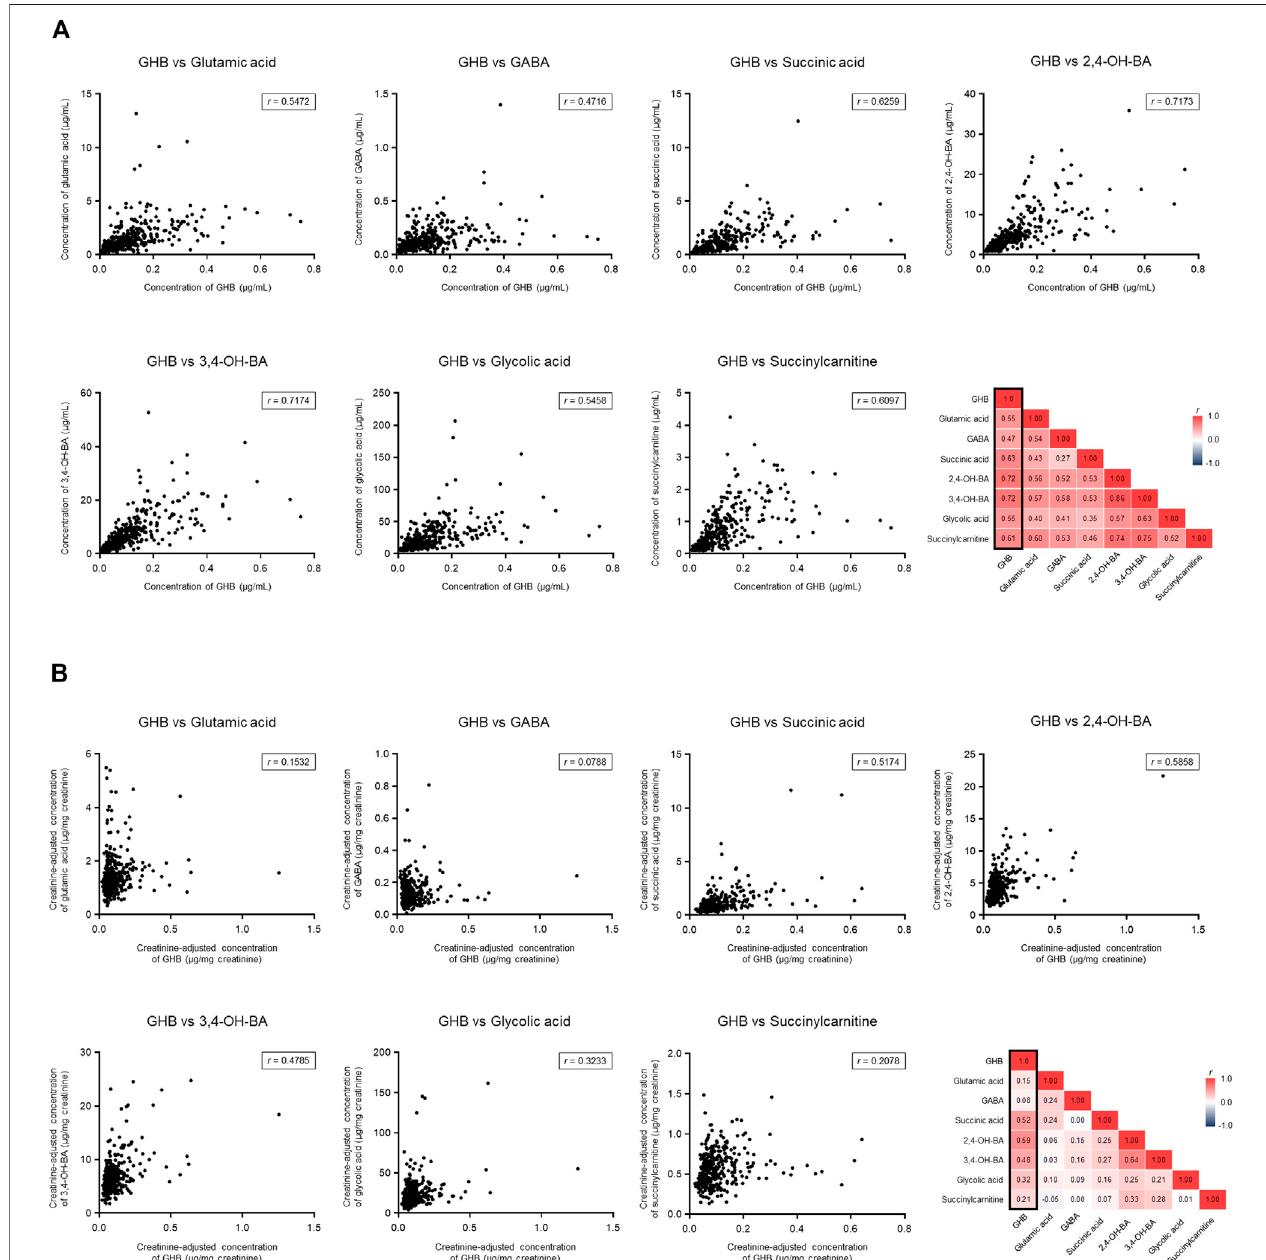
FIGURE6| Correlationbetween endogenousGHBand its biomarker metabolites. (A) Unadjustedconcentrations. (B) Creatinine-adjustedconcentrations. Values less than the limit of quanti fi cation were excluded.